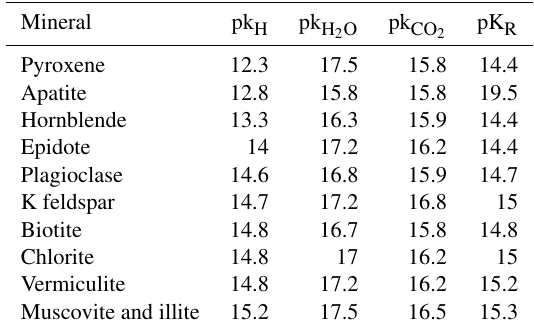
Table 3. Mineral dissolution rate coefficients (kmol c m − 2 s − 1 ) used in PROFILE for the reactions with H + , H 2 O, CO 2 and organic lig- ands (R − ) (Warfvinge and Sverdrup,